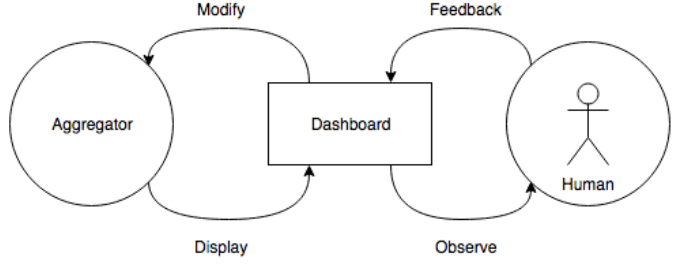
Figure 10. Interaction between human, dashboard and